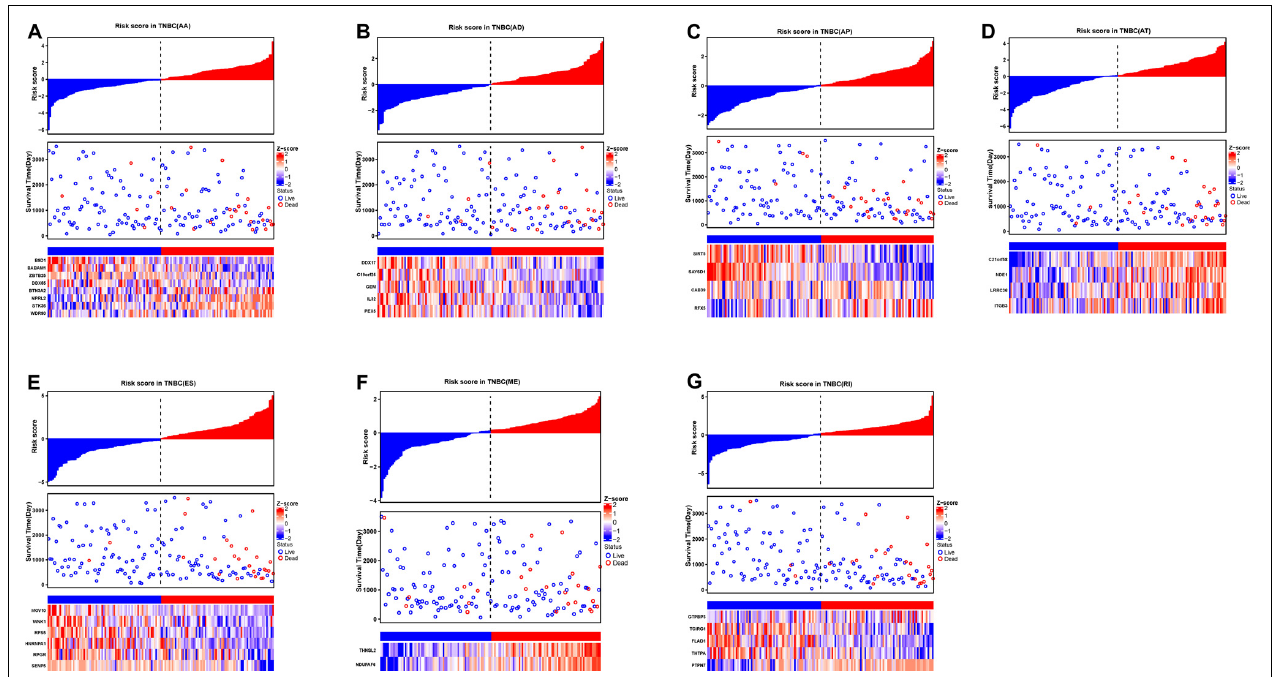
FIGURE 6 | The prognostic AS signatures for TNBC patients in multivariate Cox regression analysis. TNBC patients were divided into low- and high-risk groups according to by the median value of risk score. Risk scores were built for (A) AA, (B) AD, (C) AP, (D) AT, (E) ES, (F) ME, and (G) RI of prognosis-associated splicing events. In each subplot, the top part of the integrated graph represents risk score distribution curves, the middle part exhibit the survival time and status distributed by based on risk score, and the bottom part shows the heatmap of the normalized PSI index for each AS prognostic signature. Color from blue to red indicates the increasing z-score of PSI values from low to